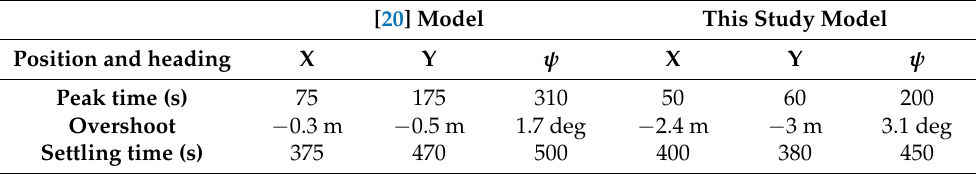
Table 5. Quantified position and heading control differences with Reference [20].